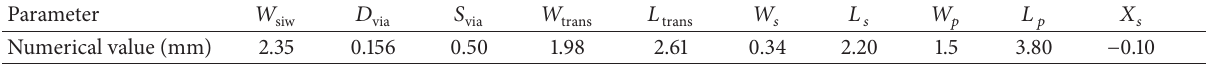
Table 1: Design parameters.